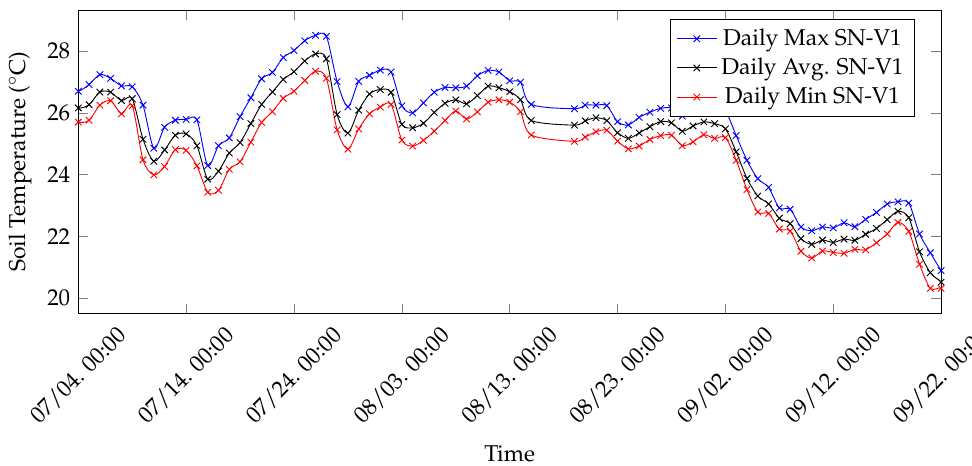
Figure 14. Soil temperatures coming from vineyard nodes (i.e., SN-V1 and SN-V2), which have been collected during three months of test in 2019.